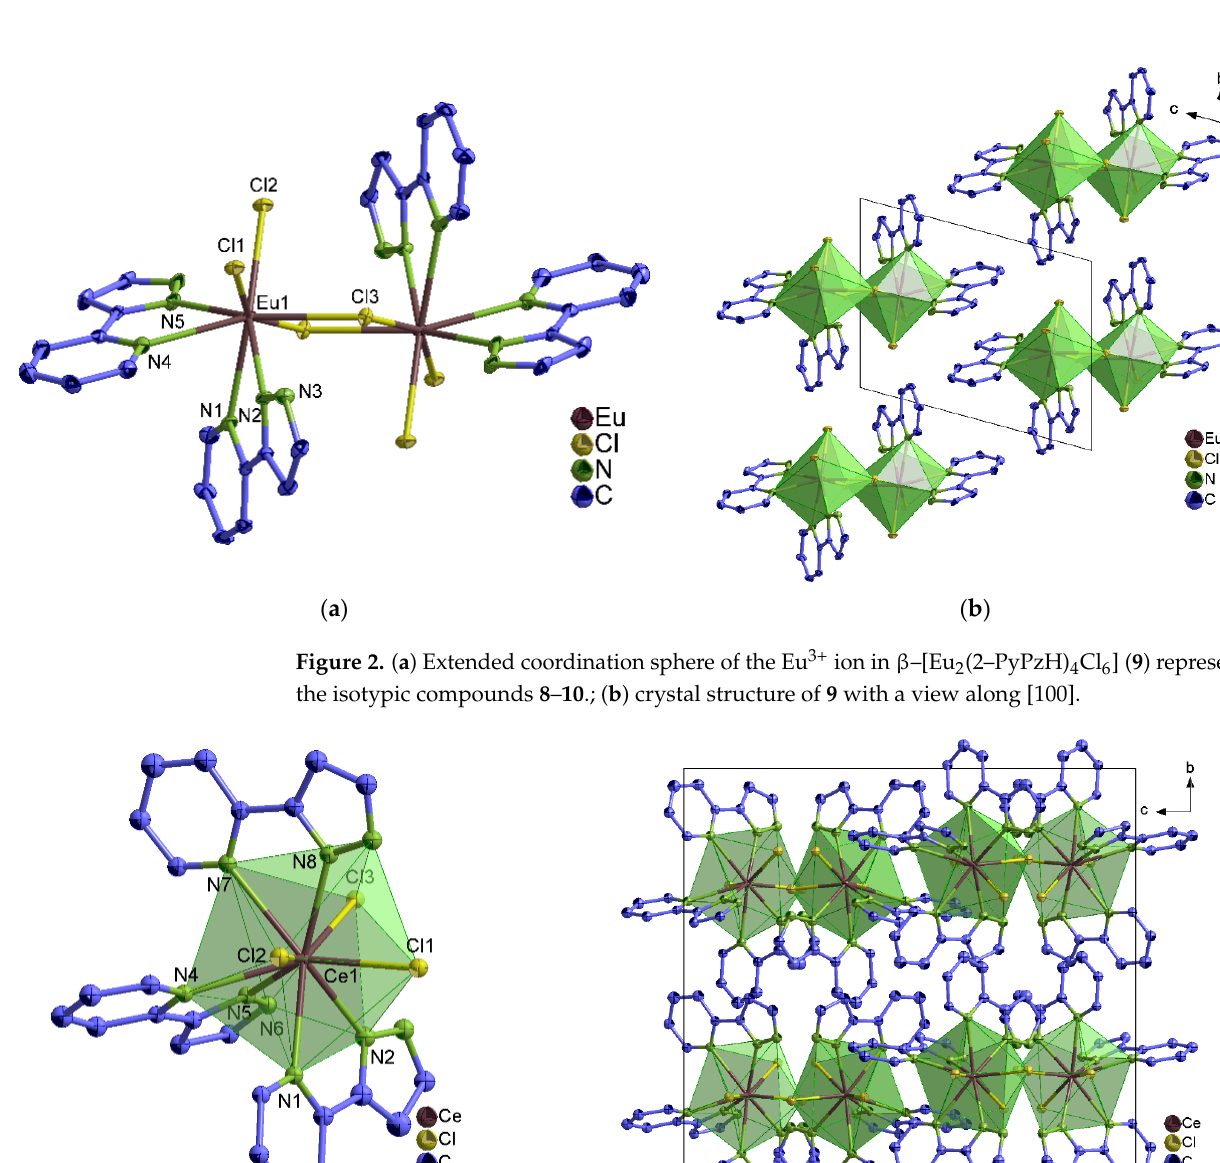
4 of 22 Figure 1. ( a ) Extended coordination sphere of the Sm 3+ ion in 1 ∞ [Sm 2 (2–PyPzH) 4 Cl 6 ] ( 3 ) representing the isotypic compounds 1 – 3 .; ( b ) crystal structure of 3 with a view along [010]. Symmetry operation: I -x+1,y,-z+1/2. In all figures, the hydrogen atoms are omitted for clarity and the coordination poly- hedra around Ln 3+ are shown in green, with thermal ellipsoids shown with a probability of 50%.